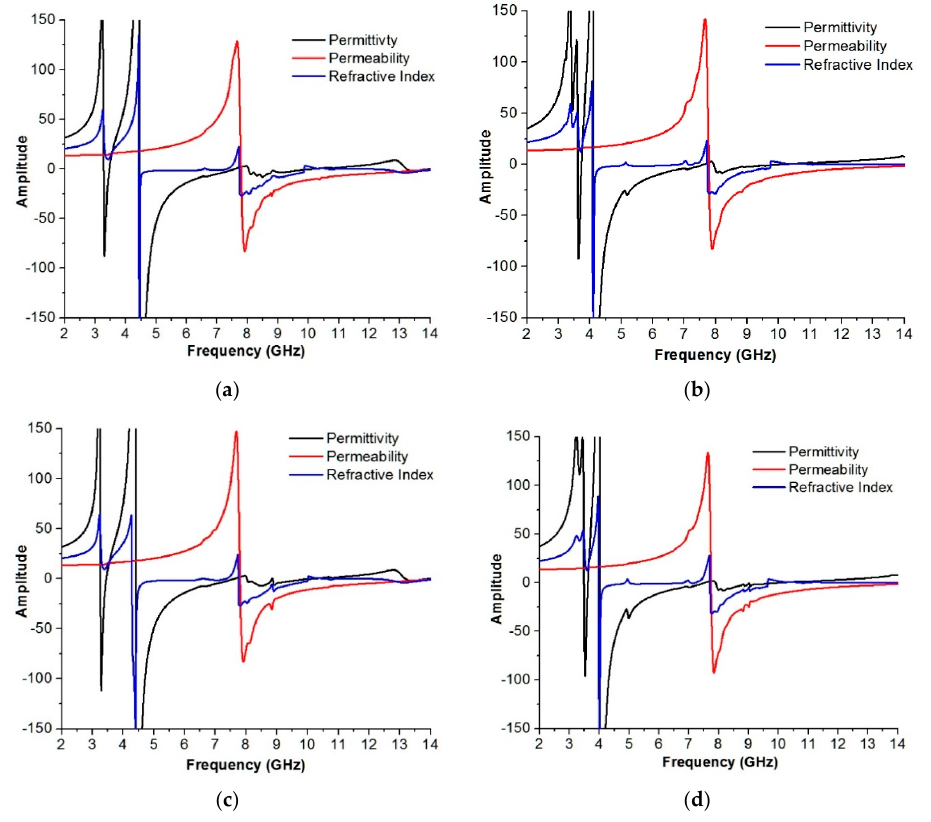
Figure 13. Amplitude of the permittivity, permeability and refractive index at: ( a ) 0°, ( b ) 90°, ( c ) 180°, ( d ) 270° rotations of the 4 × 4 array structure. Table 6. Real values of ε , µ and n at 9.20